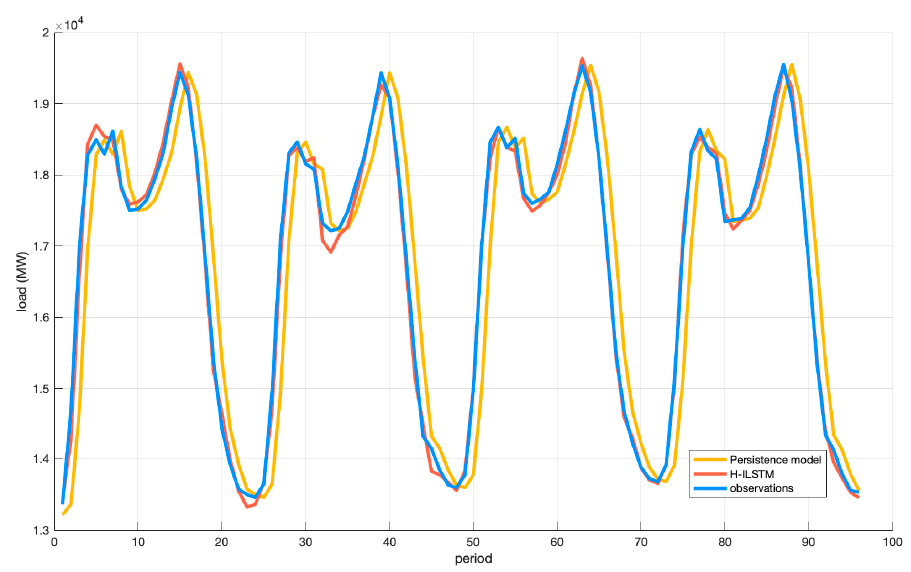
Figure 17. Forecasting performance of two models for dataset 1. Table 15. Evaluation criteria for single-step prediction under dataset 1.